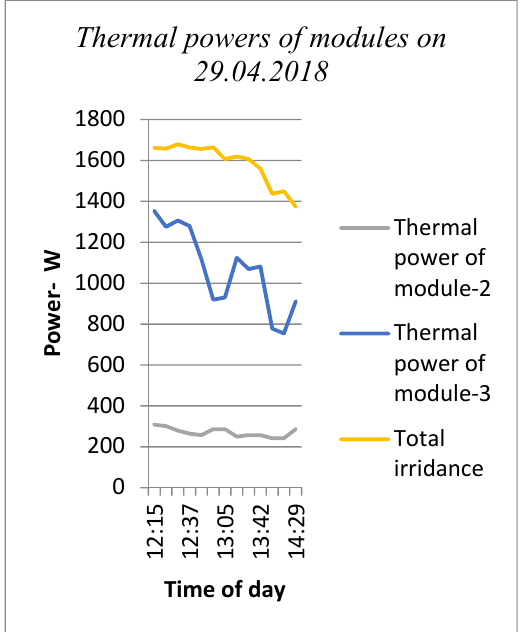
Figure 12. Thermalpowers of modules on 29.04.2018.